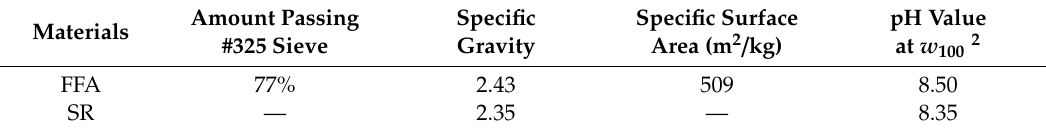
Table 2. Physical indexes of raw material SR and FFA [24].